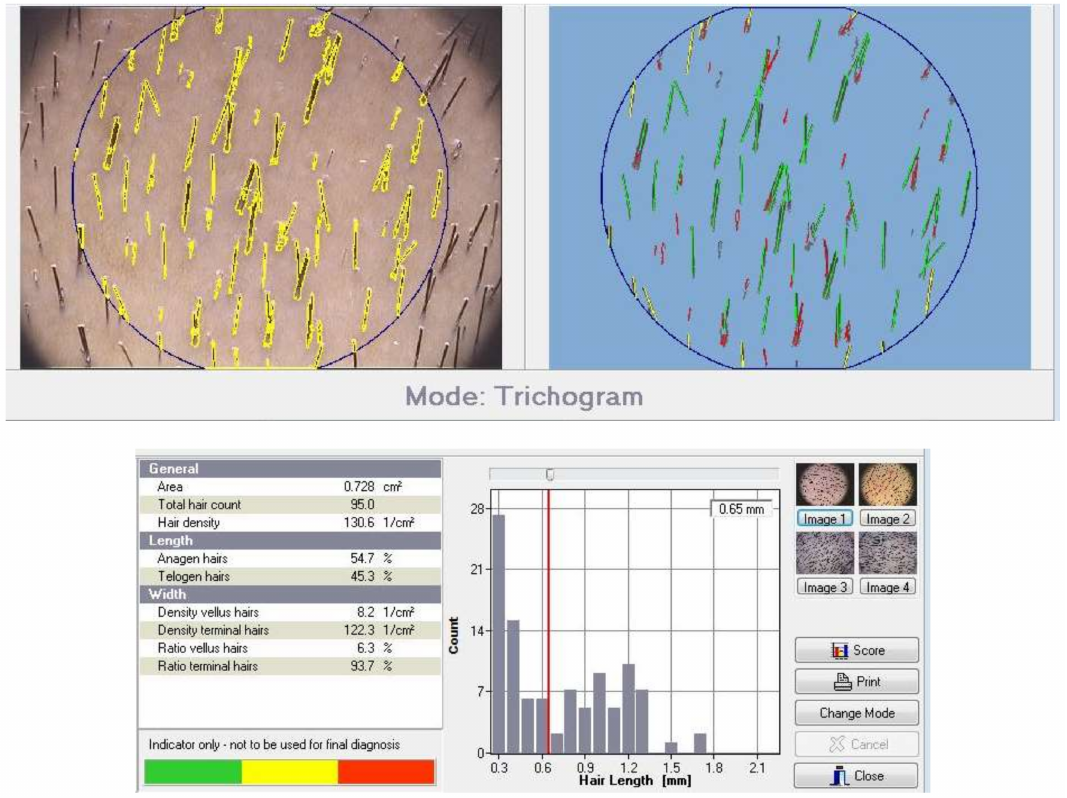
Figure 1. Example of results obtained through Trichoscan Professional Ver.